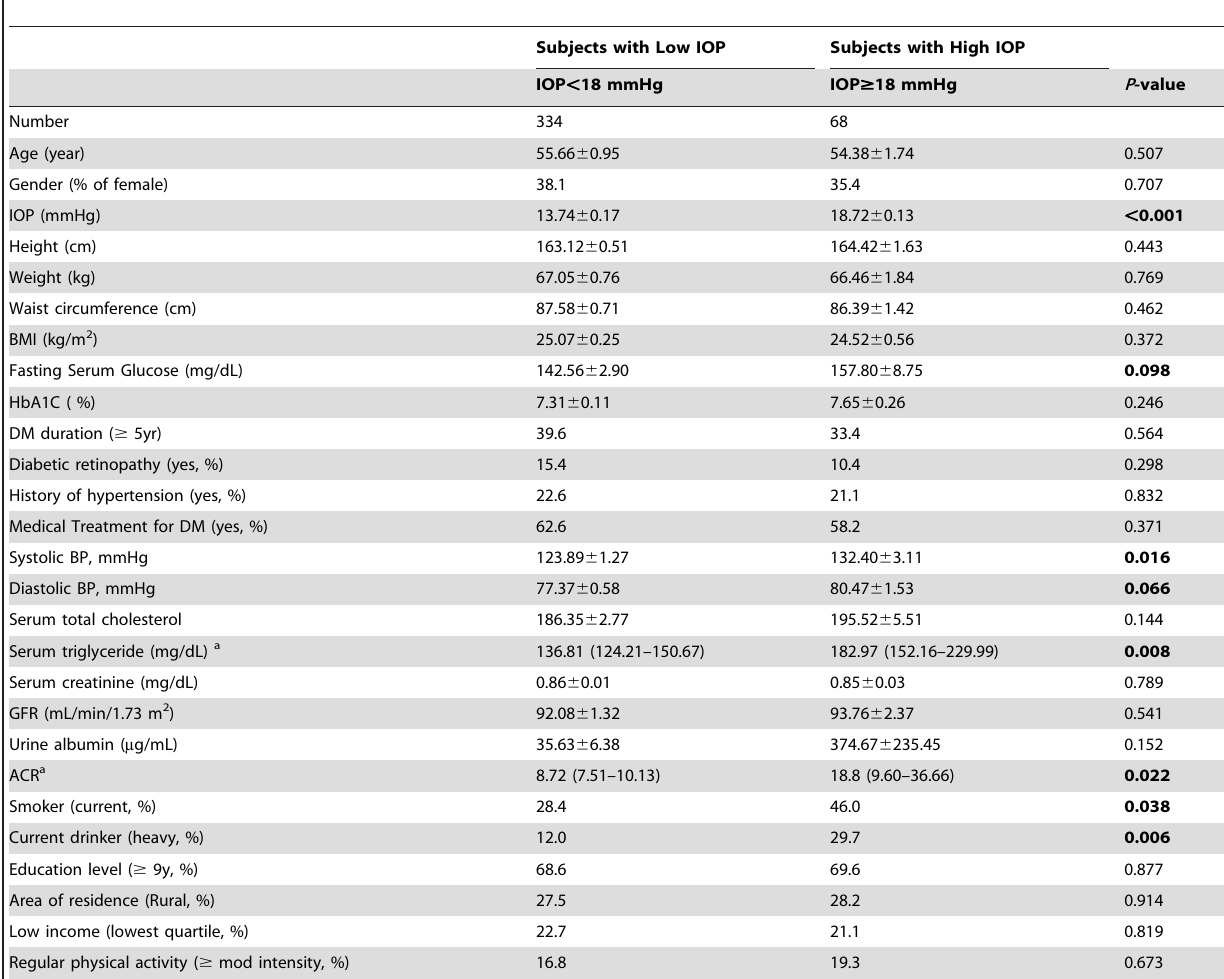
Table 1. Clinical characteristics of study subjects according to the intraocular pressure in Korean type 2 diabetic patients without renal impairment